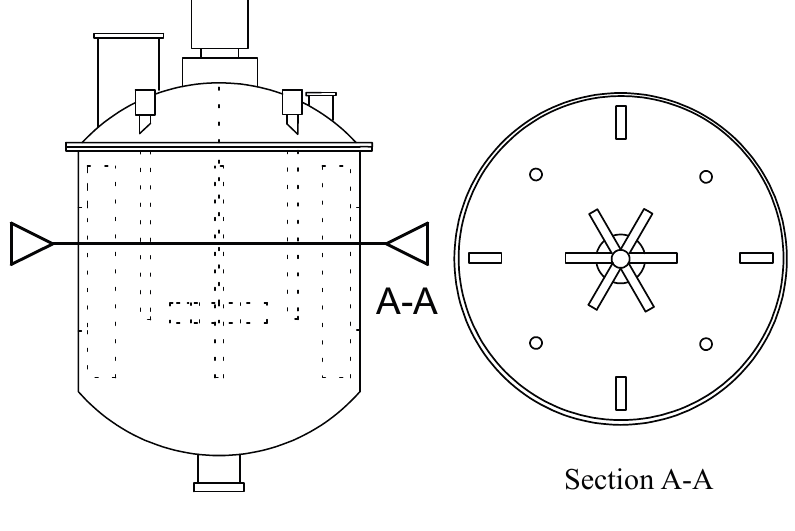
Figure 2. Leaching reactor